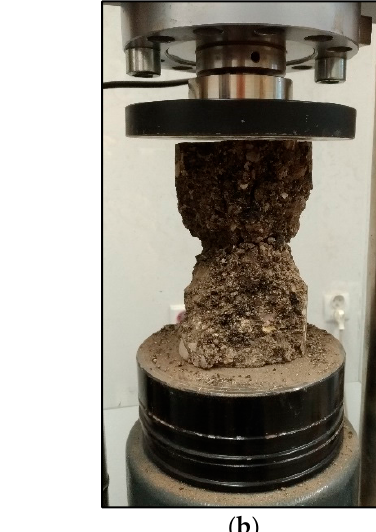
Table 13. UCS test results of the samples from REF-Mix and RCC-Mix mixtures (mean—mean value, SD—standard deviation of the sample, CoV—coefficient of variation, Δ —increase of unconfined compressive strength) [48].